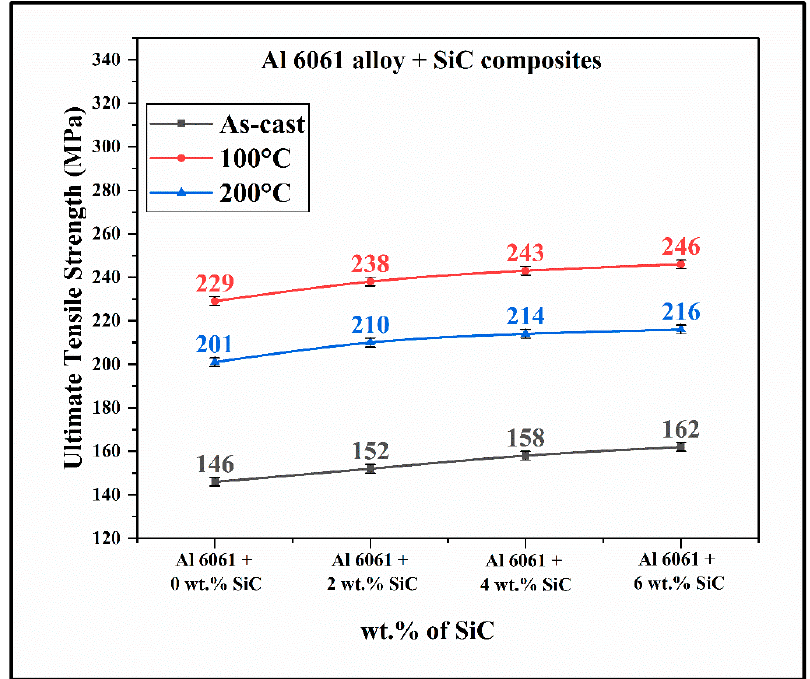
Figure 5. Variation of tensile strength with increase in content of SiC particles on Al 6061 alloy under different peak aging conditions.